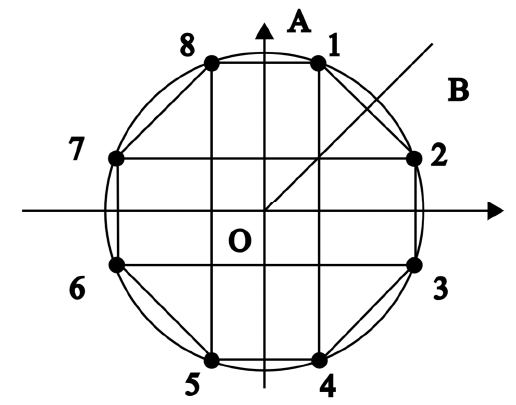
Figure 8. Construction of a circle by 8 points.